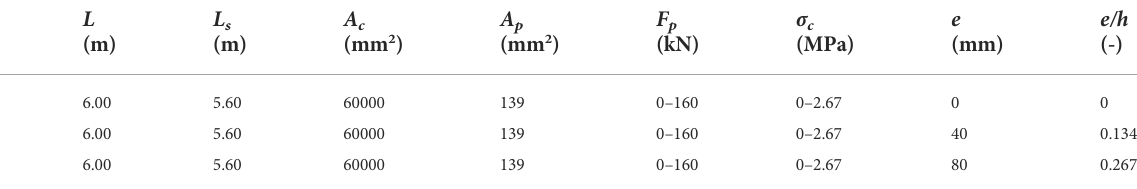
TABLE 2 Main features of the laboratory PTC